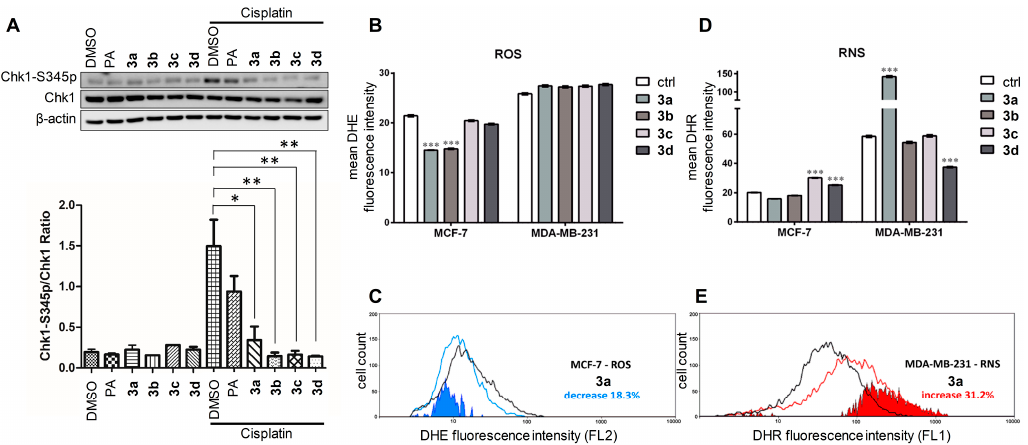
Figure 3. E ff ect of compounds 3a – d on the DNA damage response and redox balance in breast cancer cells. ( A ) E ff ect of compounds 3a – d on Chk1 phosphorylation in MCF-7 cells, PA: